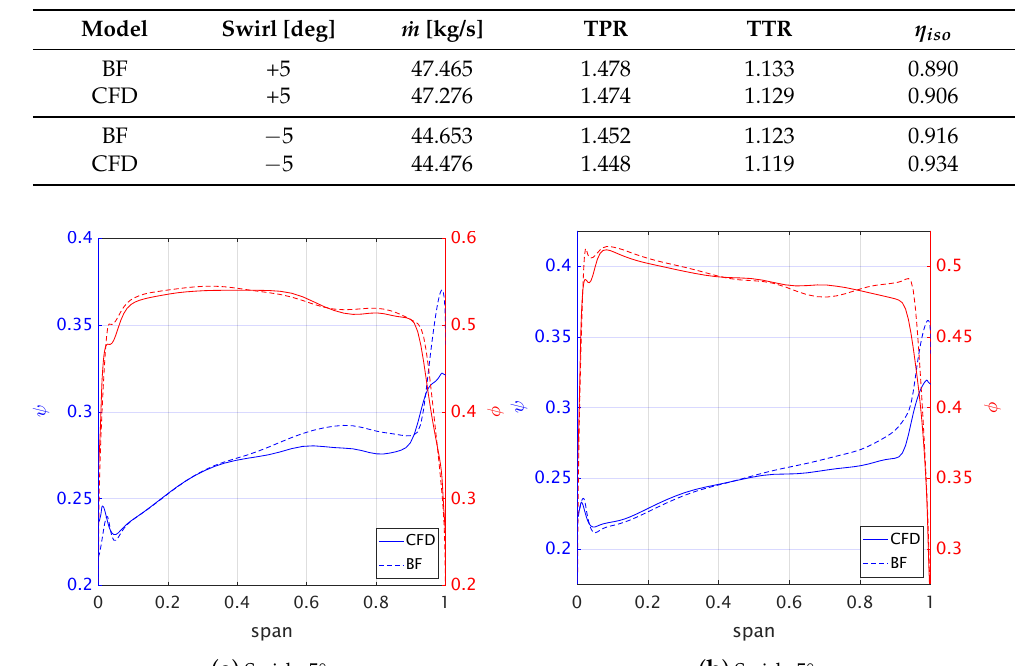
Table 3. Swirl flow calculations near peak efficiency.